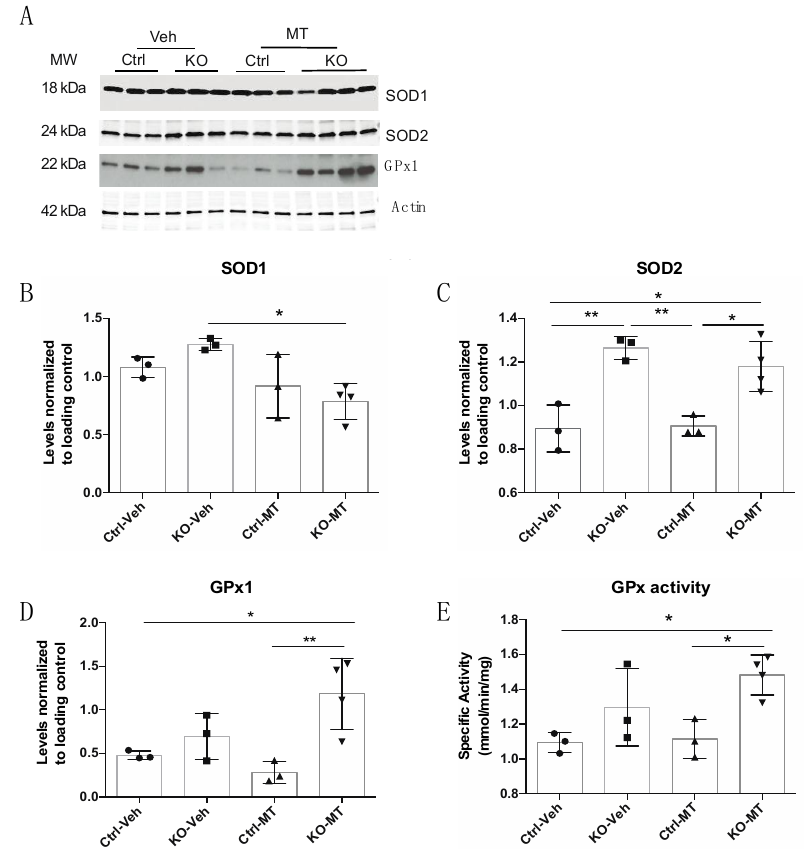
Figure 4. Analysis of cellular antioxidants in piriform cortex of the neuron-specific RISP KO mice treated with mitoTEMPO. ( A ) Steady-state level of antioxidant enzymes in control and RISP KO mice treated with vehicle or 10 mg/kg/day mitoTEMPO (MT) was determined by SDS-PAGE followed by western blot with specific antibodies. Molecular weight (MW) for each protein is indicated in the figure; ( B – D ) Quantification of levels of SOD1, SOD2 and GPx1 normalized to actin; ( E ) Enzymatic activity of glutathione peroxidase determined spectrophotometrically in piriform cortex homogenates. Each symbol represents one mouse ( n = 3–4) and lines in graphs represent mean and standard deviation. Statistical significance was determined by one-way ANOVA followed by Tukey’s multiple comparison test. (*) p < 0.05 and (**) p < 0.01 indicate statistical